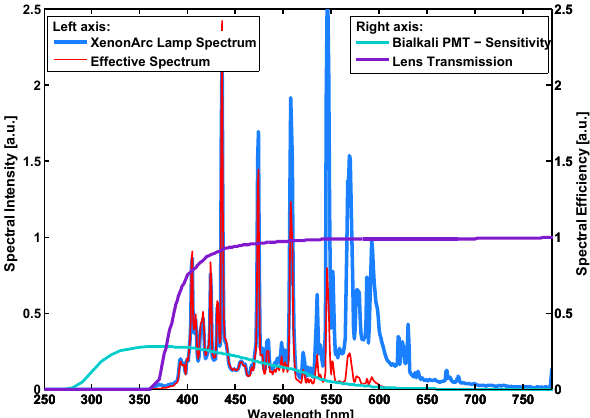
Figure 2. The effective light spectrum (red line; a.u.), which is rel- evant for scattering cross section calculations, is obtained by multi- plication of the xenon arc lamp light spectrum (blue line; a.u.) with the wavelength-dependent lens transmission (WELAS light collec- tion optics; purple line; absolute values) and bialkali PMT sensi- tivity (turquoise line; a.u.) and an arbitrary constant scaling factor (chosen to get equal values of the red and blue lines at 450nm wave-